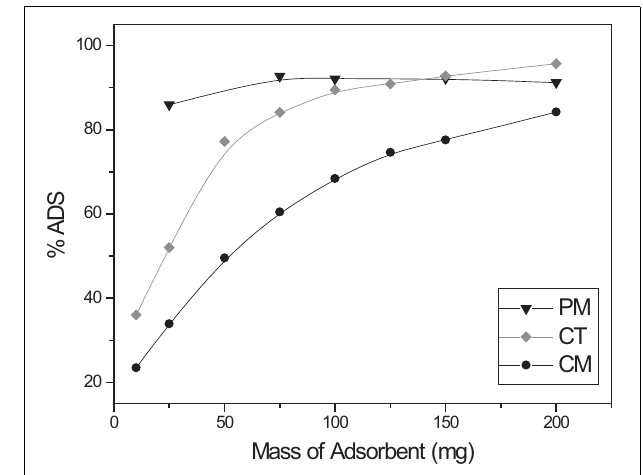
FIGURE 2 | Role of the pH on the adsorption of BY57 onto the lignocellulosic materials. FIGURE 3 | Effect of adsorbent dosage on the adsorption of